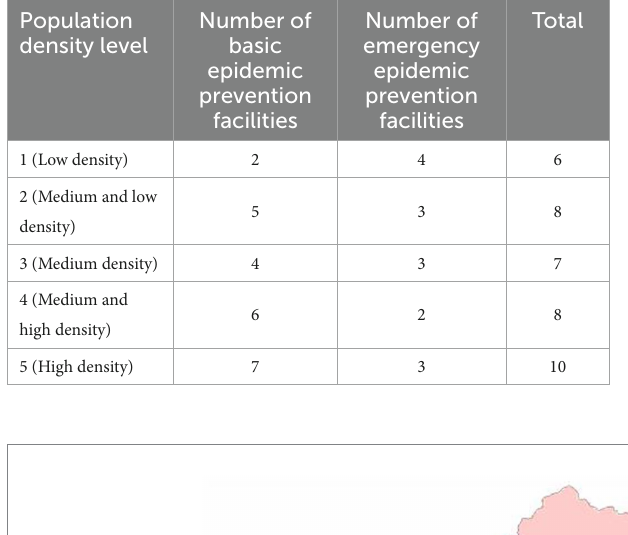
TABLE 2 The number of epidemic prevention facilities and the level of population density.